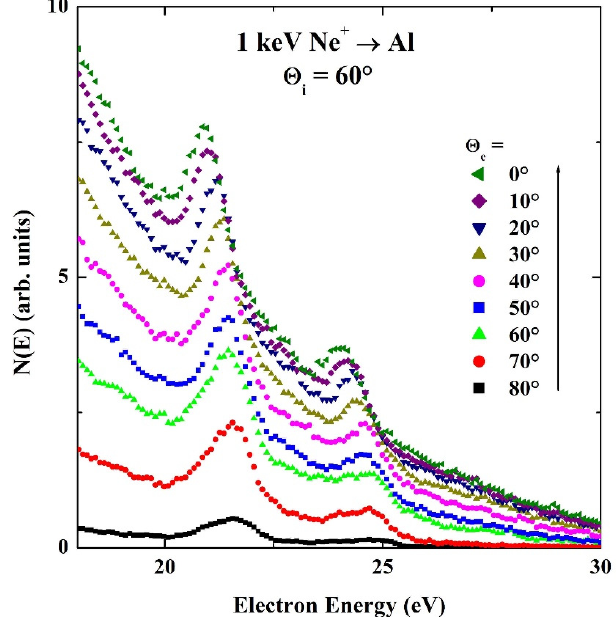
Figure 10. Ne I and Ne II autoionization spectra as a function of the observation angle Θ e , for Ne + ions energy E 0 = 1 keV and at fixed incidence angle Θ i = 60°.